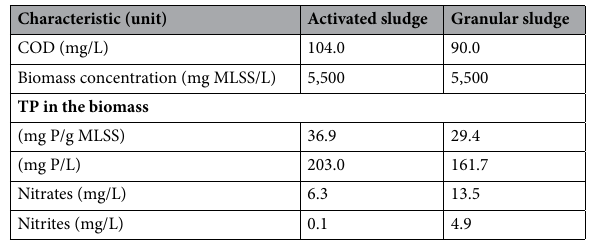
Table 1. Characteristics of the liquid phase and sludge at the beginning of the